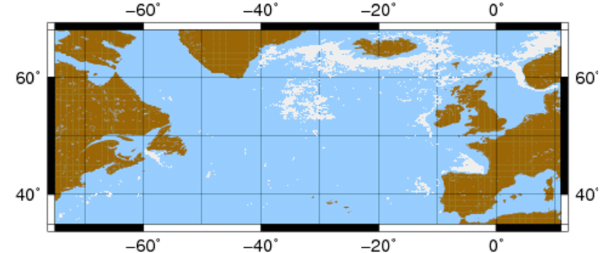
Fig. 1. The study region. The white regions show the spatial dis- Figure 1 The study region. The white regions show the spatial distribution of open ocean tribution of open ocean ( > 200m) Emiliania huxleyi blooms during (>200 m) Emiliania huxleyi blooms during April to August as detected by the Earth April to August as detected by the Earth observation (EO) data used observation (EO) data used in this study (1998-2007). Land is in brown. A white pixel shows in this study (1998–2007). Land is in brown. A white pixel shows that an instance of an Emiliania huxleyi bloom has appeared once or more within the 1998- that an instance of an Emiliania huxleyi bloom has appeared once 2007 time series. or more within the 1998–2007 time